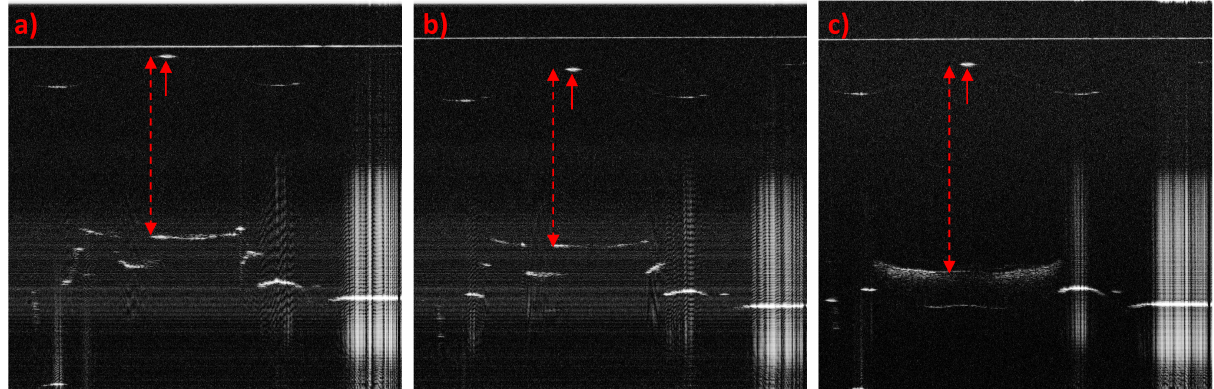
Figure 14. B-scans of overmoulded FOTs. The B-scans were taken through the center of the lens so that the lens apex was visible (small, red arrow). The center thickness of the moulded material can be calculated (red, dashed arrow). Because of the lens-shaped surface the OCT signal of the LED and die were distorted so their surface no longer appeared flat. Samples ( a , b ) are successfully overmoulded FOTs, and sample ( c ) is a scrap part, which can be seen in the significantly larger center thickness and the different appearance of the